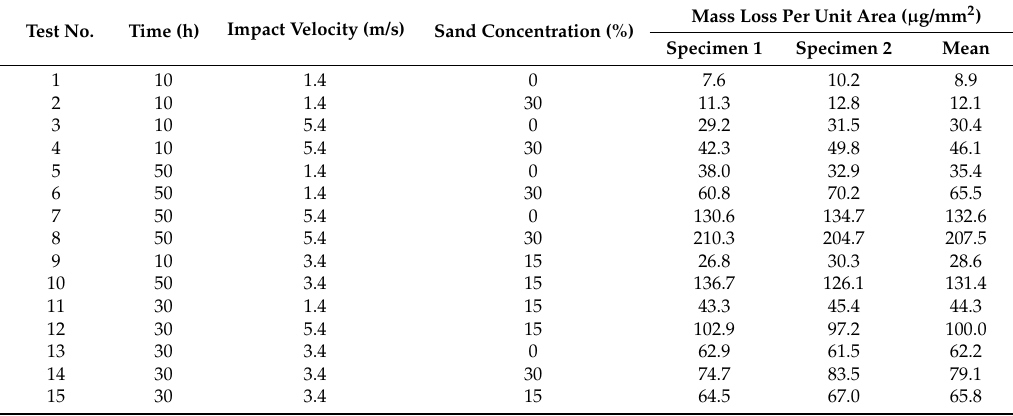
Table 4. Test results from the E-C